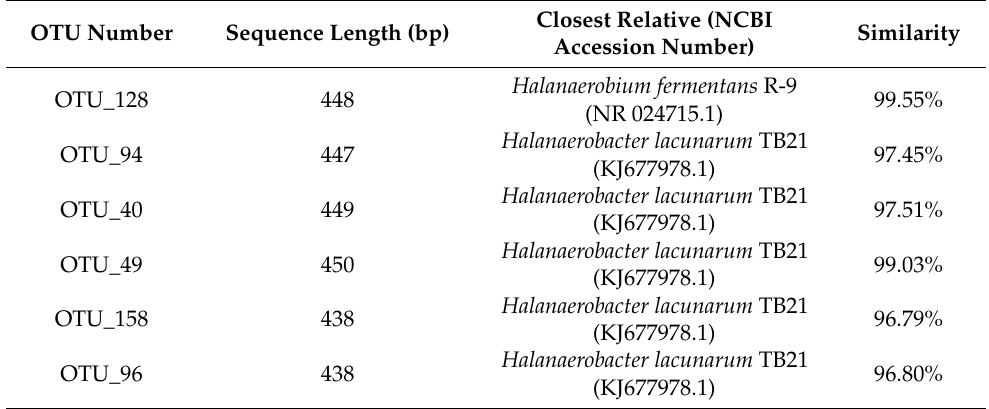
Table 2. Phylogenetic identification results of the most abundant OTUs (data from [28]). OTU Number